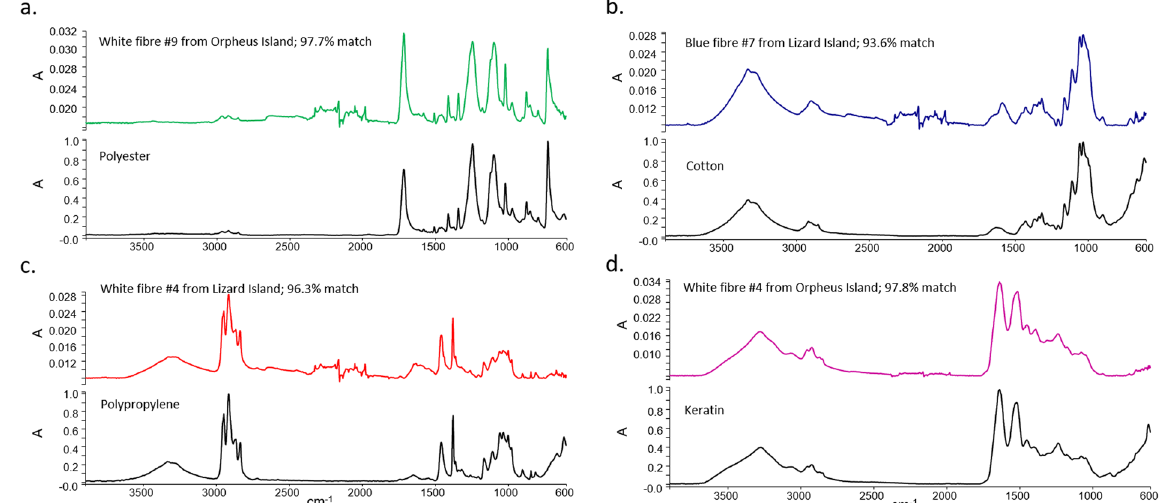
Figure 2. ATR-FTIR spectral matches of representative marine microdebris in juvenile coral trout. Marine microdebris, including fibres consisting of ( a ) polyester, ( b ) cotton, ( c ) polypropylene, and ( d ) keratin, were detected in the gastrointestinal tract of 20 individual juvenile coral trout ( Plectropomus leopardus and P. maculatus ), collected on reefs around four reef islands in the Great Barrier Reef World Heritage Area, Australia, in 2011.